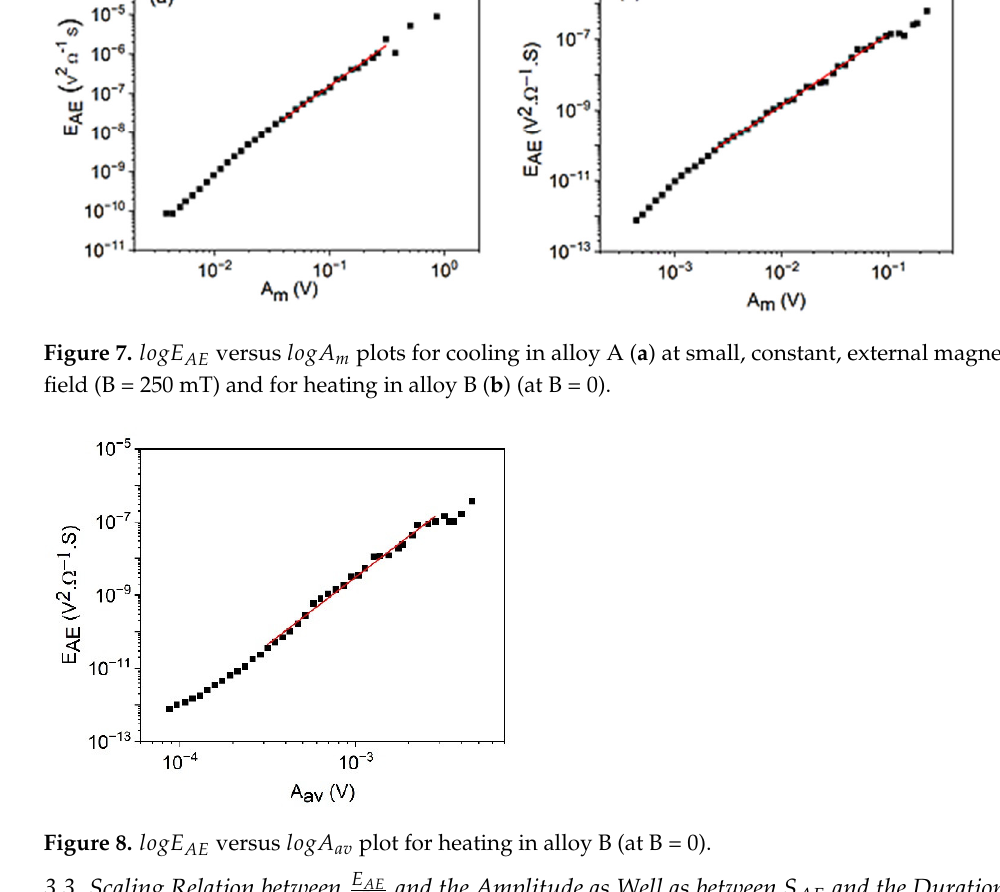
Figure 10.     versus   plot for heating in alloy B (at B = 0). The slope is 2.30 ± 0.05.